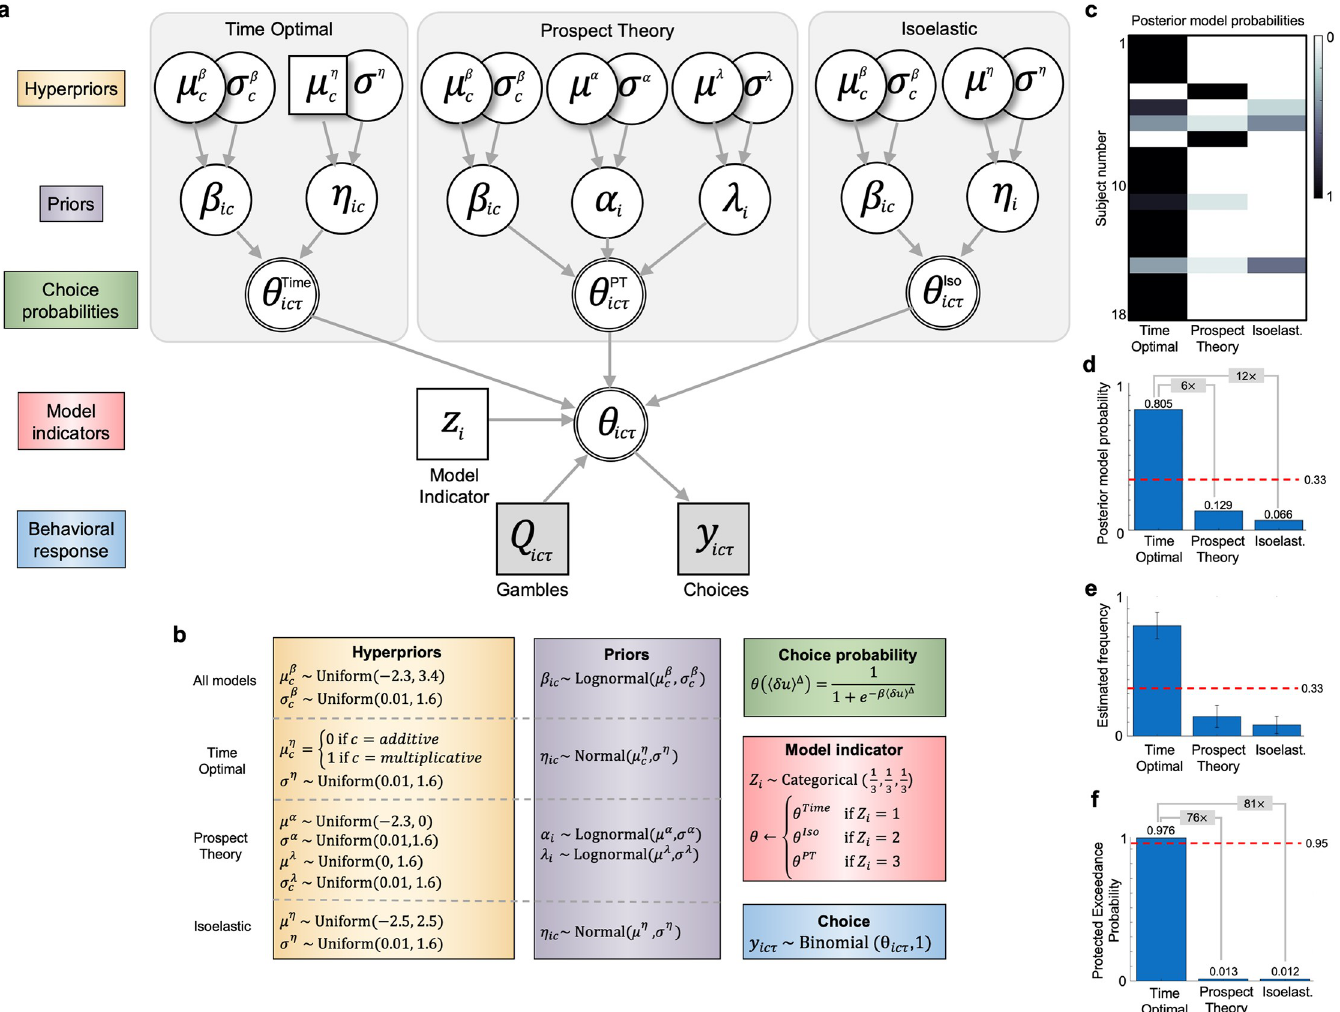
Fig 4. Bayesian hierarchical latent mixture model and model selection results. A, graphical model according to conventions of Fig 3. This model adds a model indicator variable (z) to modelling latent mixtures of the three different utility models nested within it. Note that for prospect theory risk preference parameter α , there is one parameter for gains, and another for losses. B, hyperprior and prior distributions, including structural equations, choice functions, and choice generating distributions. Hyperpriors for α are duplicated to model gains and losses separately. C, posterior model probabilities for each model based on the model indicator variables representing each utility model. D , posterior model probabilities summed over subjects, with the red bar indicating prior probabilities assuming equal prior probability for the three utility models. E , estimated model frequencies from the cohort and error bars as standard deviations. F, protected exceedance probabilities for each utility model being the most